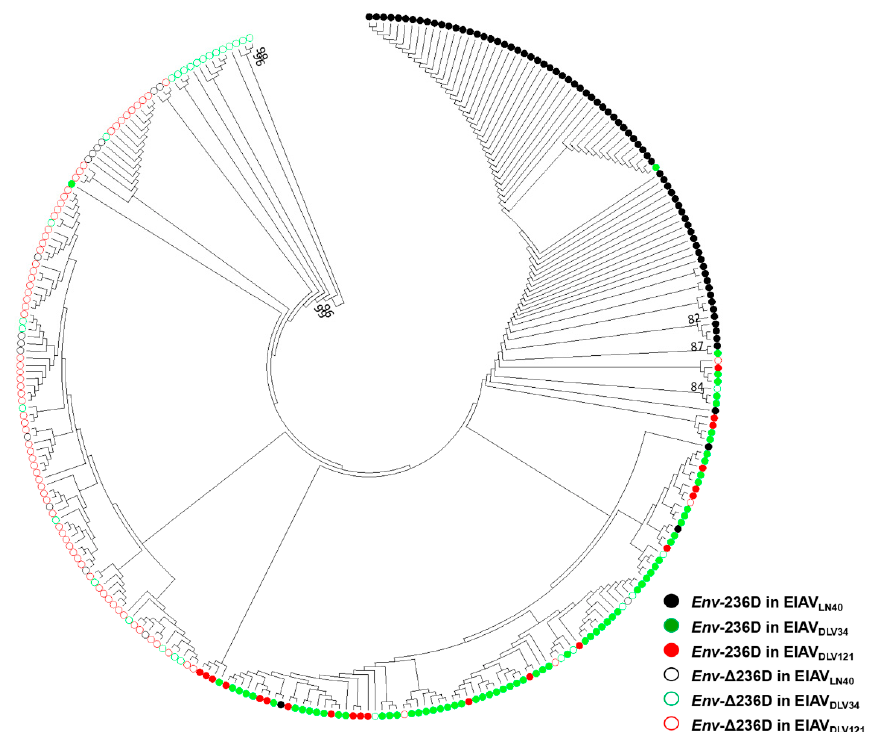
Figure 3. Construction of a maximum likelihood tree using the MEGA 7.0 program based on the Tamura-Nei model. Bootstrap values above 80% are indicated. EIAV LN40 , EIAV DLV34 , and EIAV DLV121 are shown in black, green and red, respectively. Solid and hollow circles represent the env -236D-phenotype and env - Δ 236D-phenotype sequences, respectively. All samples were collected from three virus strains (EIAV LN40 , EIAV DLV34 , and EIAV DLV121 ). A total of 381 sequences were analyzed.